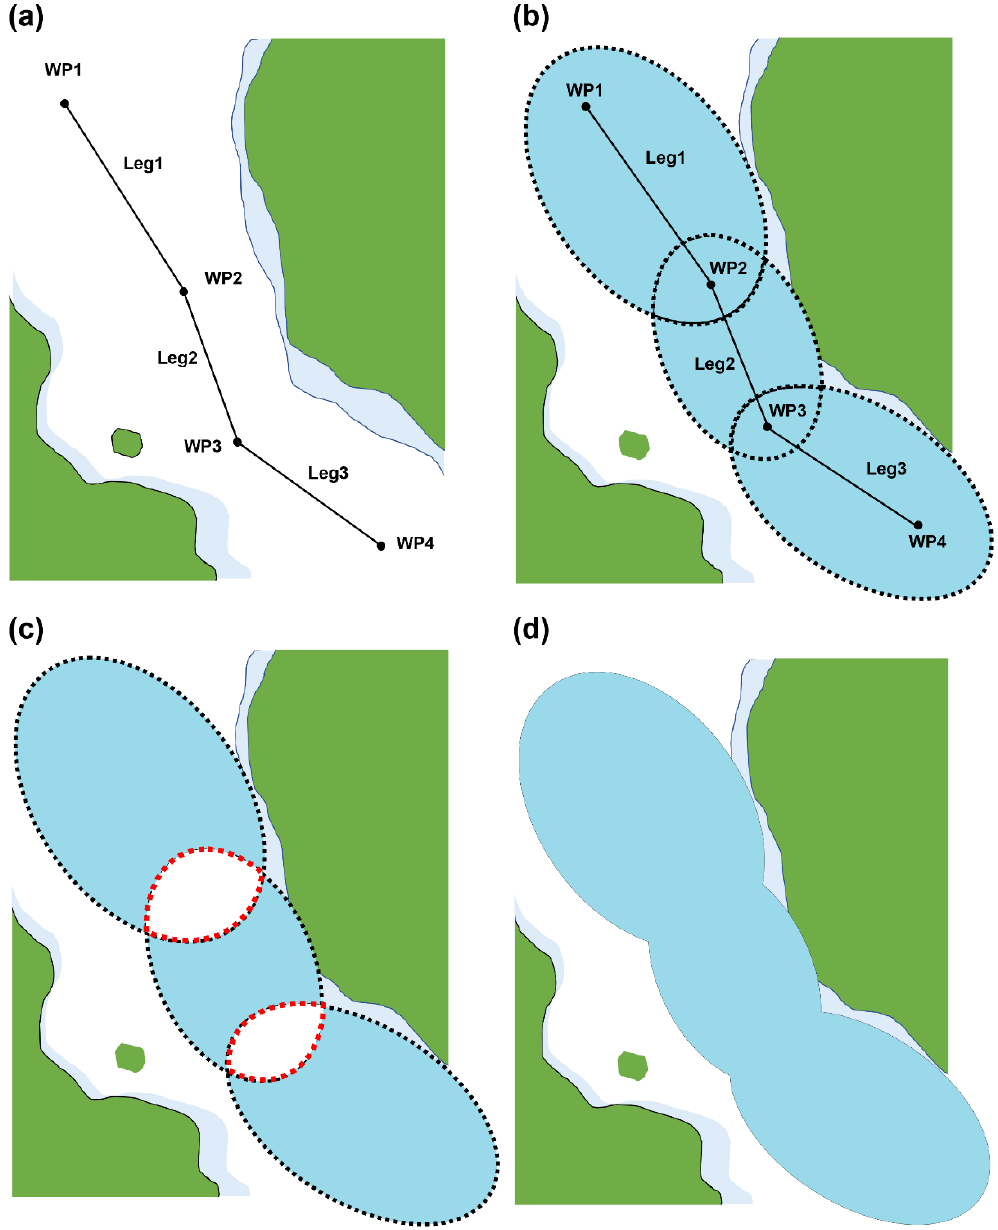
Figure 14. The multi ‐ ellipse map process: ( a ) Initial route data, ( b ) create an ellipse through each leg data, ( c ) calculation of symmetrical difference set, and ( d ) create a multi ‐ ellipse space.